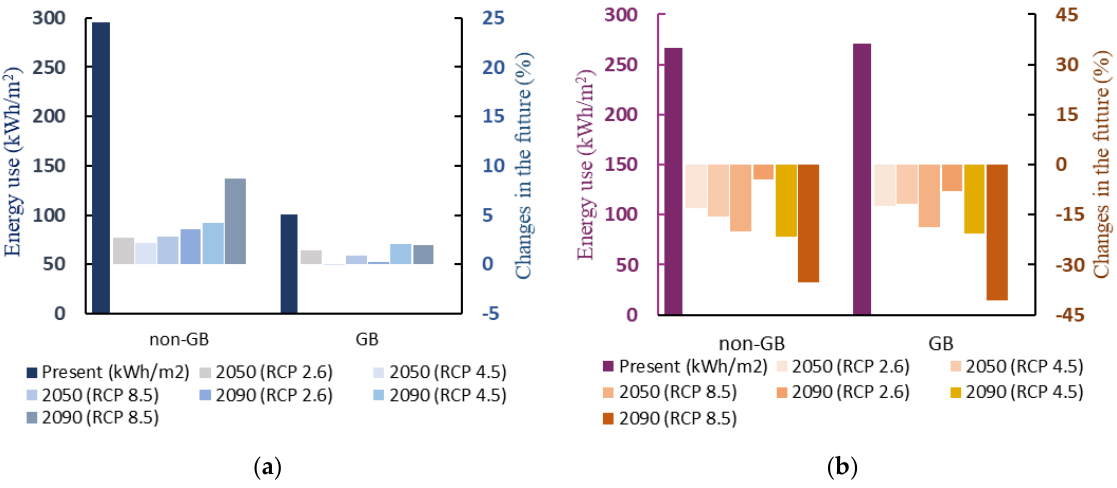
Figure 7. Simulation results of the peak loads for the GB and non-GB: ( a ) cooling; ( b ) heating.